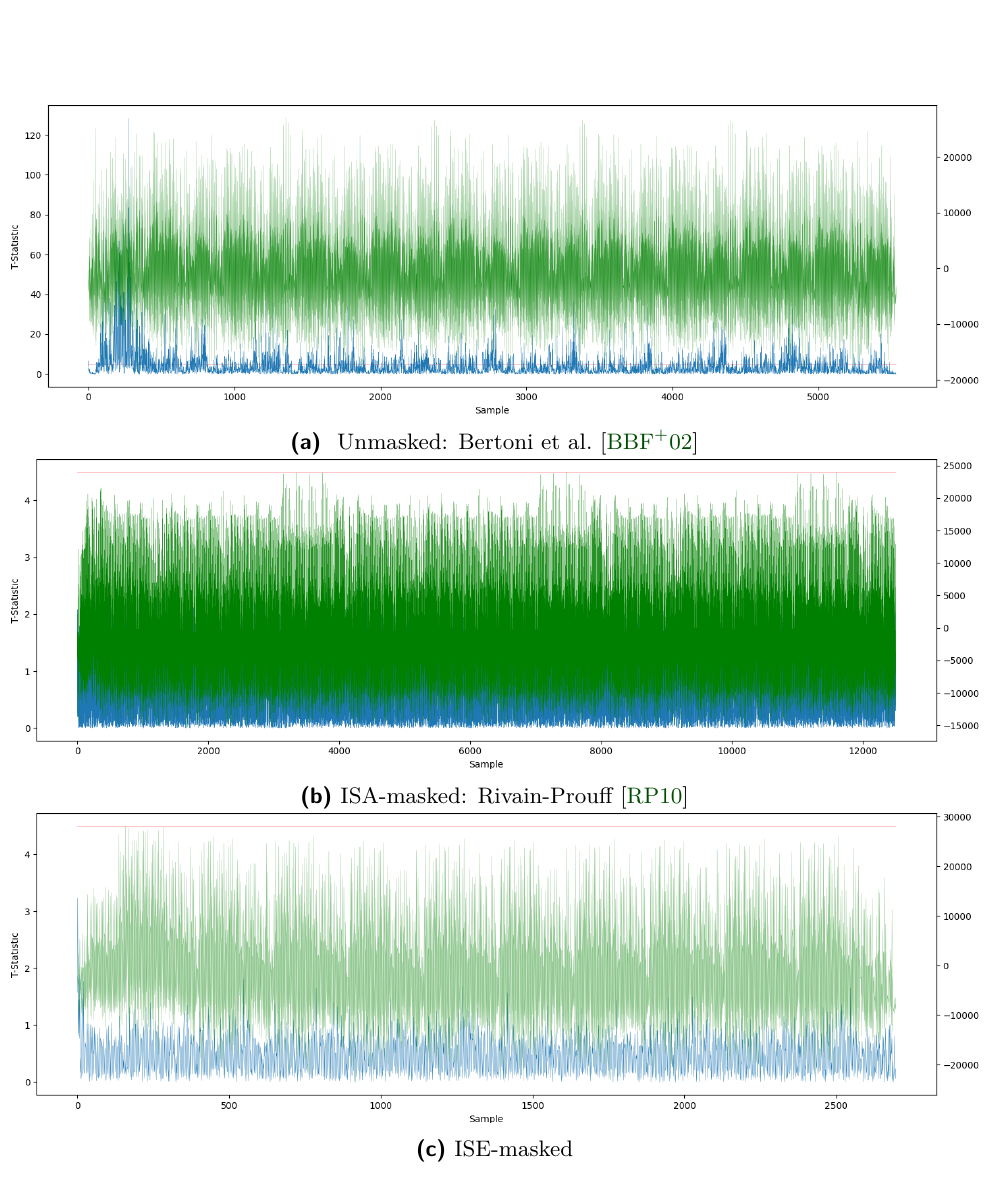
Figure 5: Comparison of leakage for unmasked, ISA-masked, and ISE-masked implementa- tions of (the Encrypt kernel of) AES as executed on the SCARV core. Each case relates to a set of 100 , 000 power consumption traces: the green plot shows the average of said traces, whereas the blue plot shows the (absolute) t-statistic stemming application of TVLA-based leakage detection to